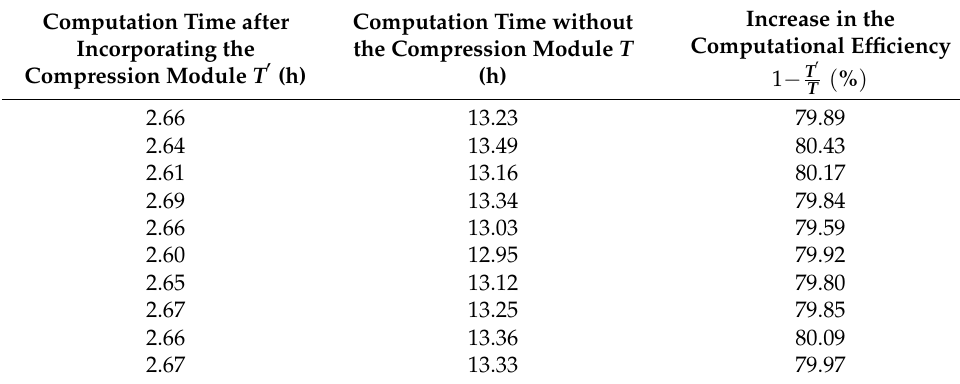
Table 3. Comparisons of the computation time.